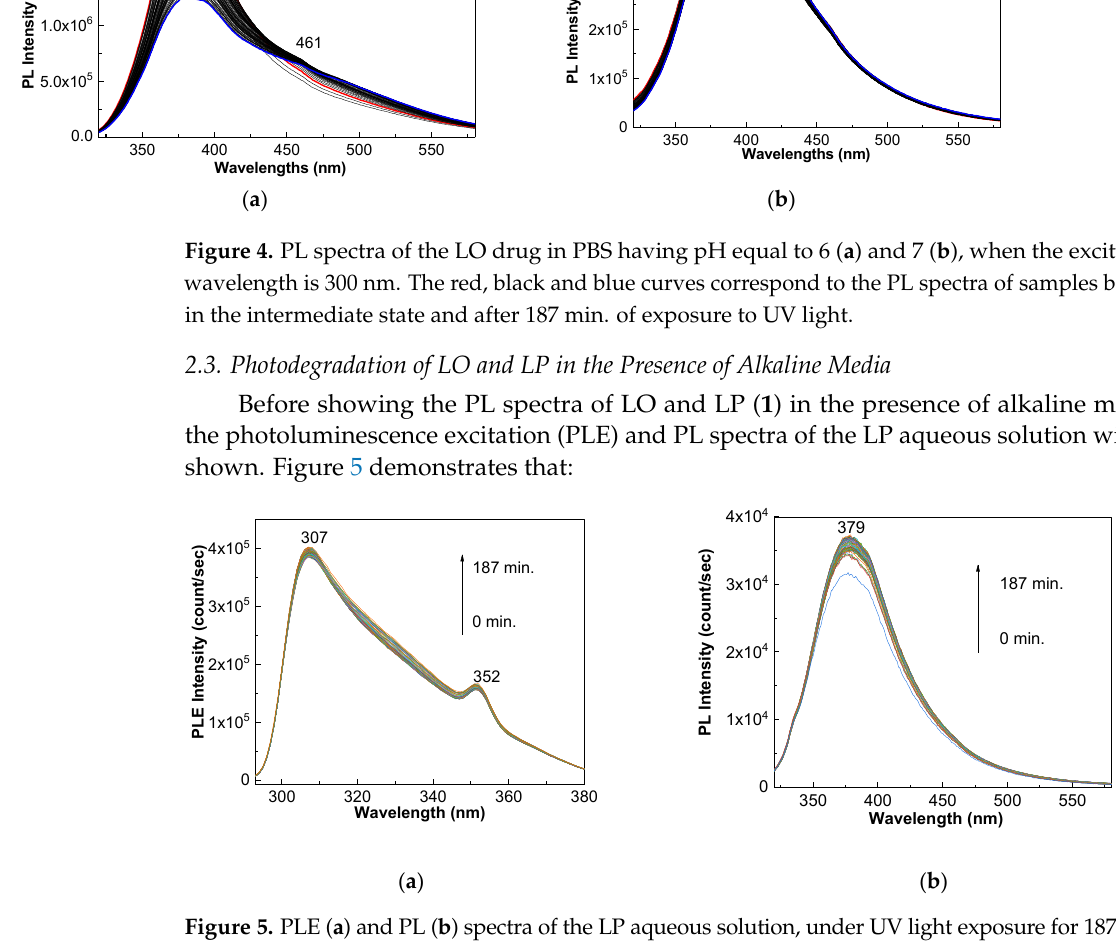
Figure 4. PL spectra of the LO drug in PBS having pH equal to 6 ( a ) and 7 ( b ), when the excitation wavelength is 300 nm. The red, black and blue curves correspond to the PL spectra of samples be ‐ fore, in the intermediate state and after 187 min. of exposure to UV light.